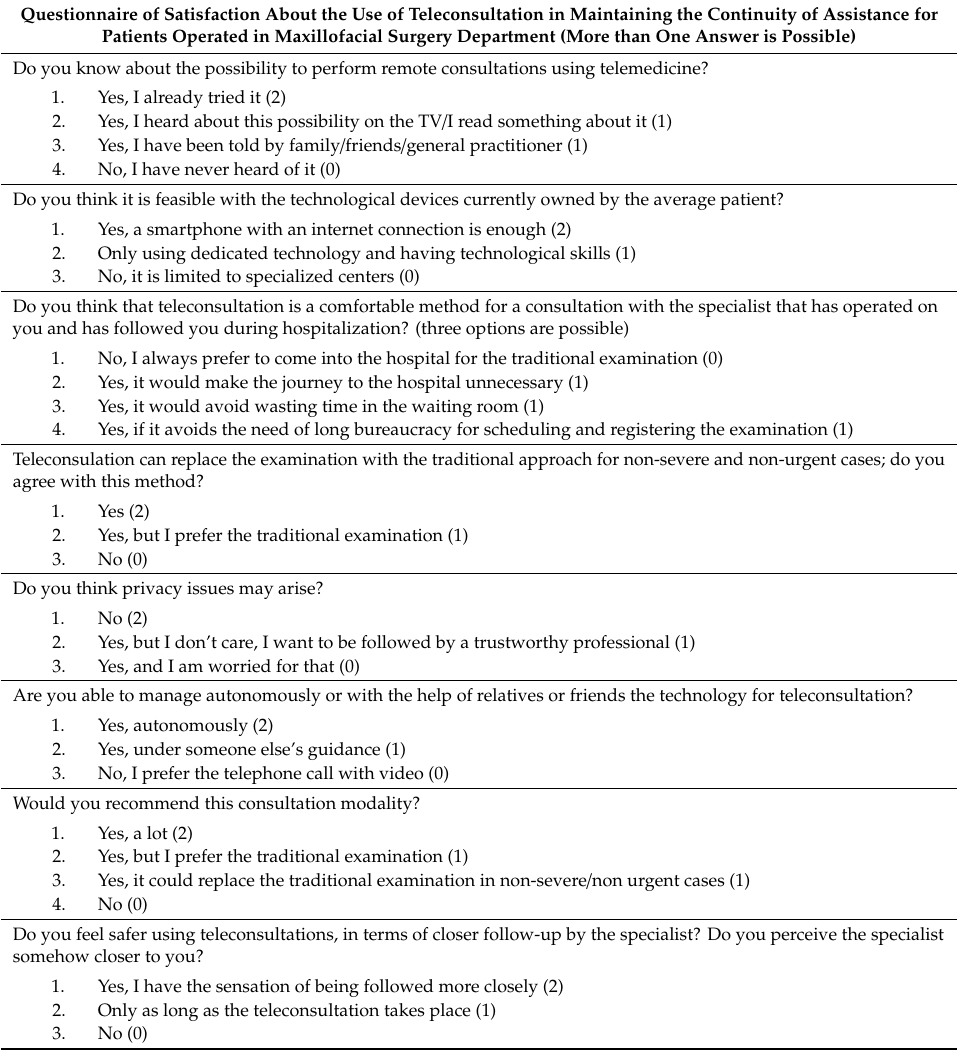
Table 2. Satisfaction questionnaire to assess patients’ perception of